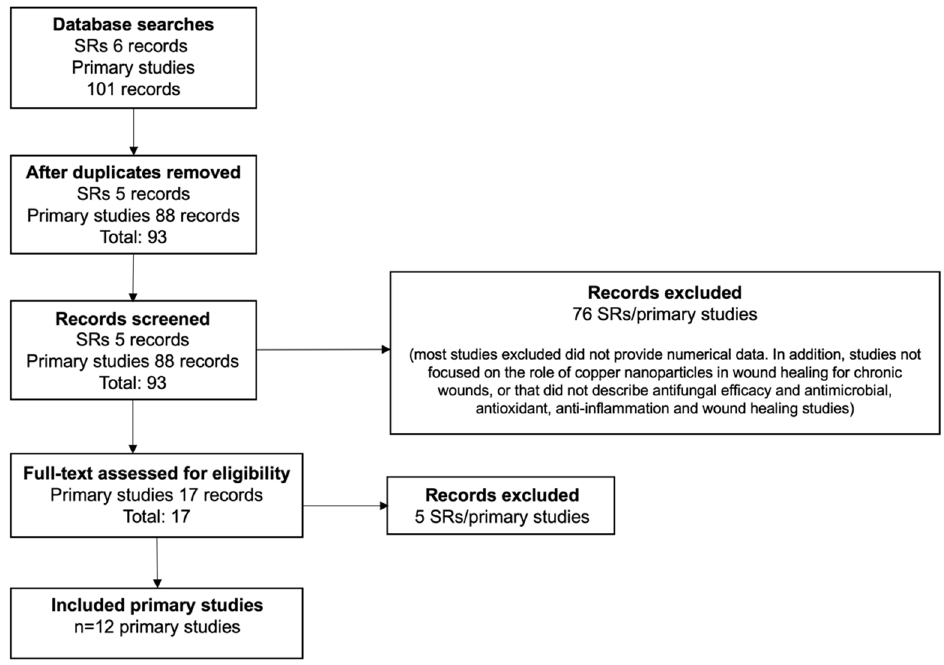
Figure 1. PRISMA flow diagram. SR: systematic review.